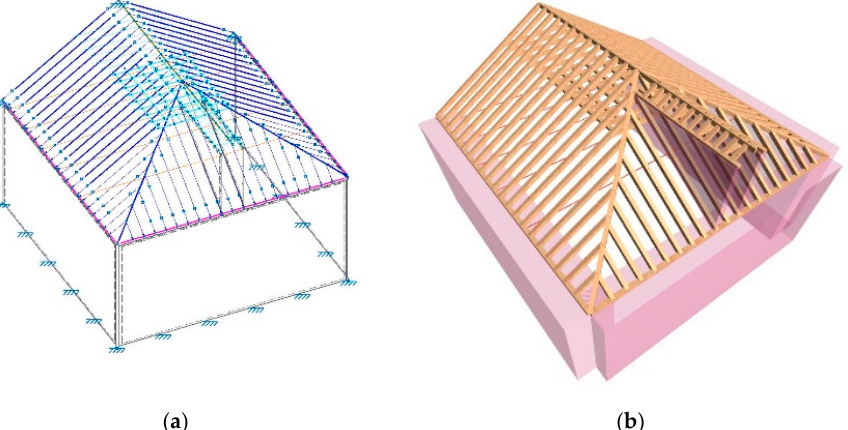
Figure 18. Structure models: ( a ) structure modelled in CYPE software; ( b ) realistic representation of the CYPE model.